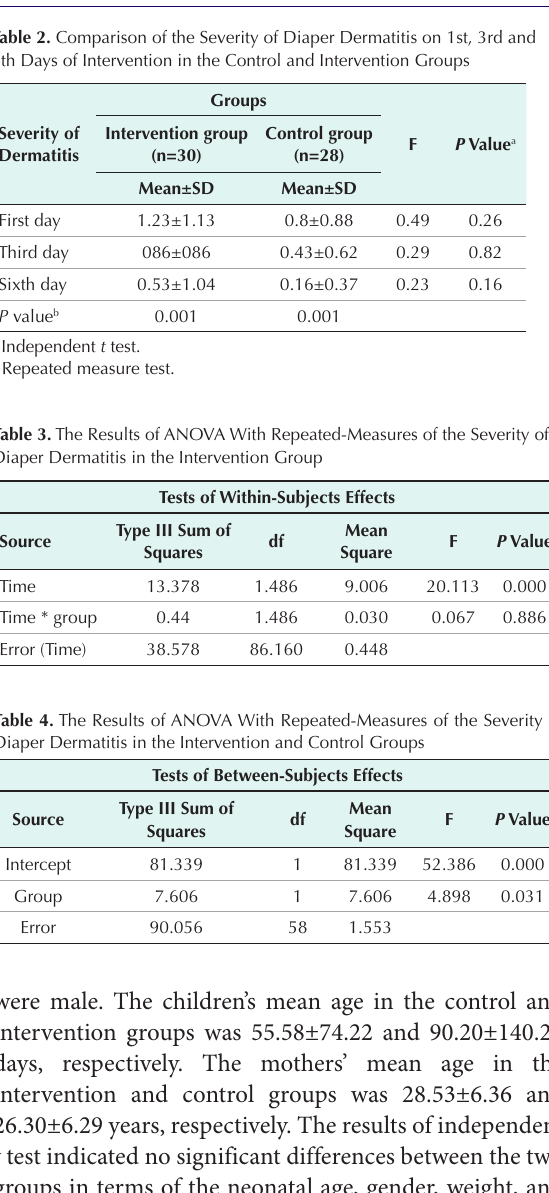
Table 1. Comparison of the Severity of Diaper Dermatitis Based on Mother and Child Age and Child Weight Variable